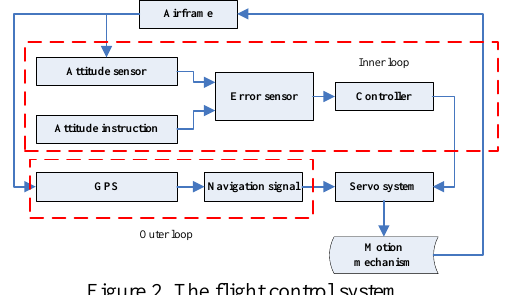
Figure 2. The flight control system